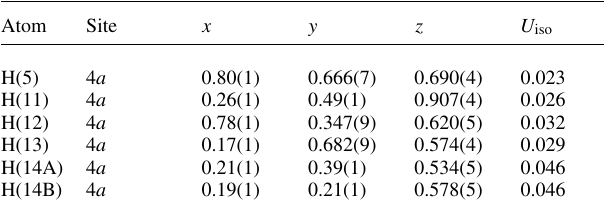
Table 2. Atomic coordinates and displacement parameters (in Å 2 ) . Table 1. Data collection and